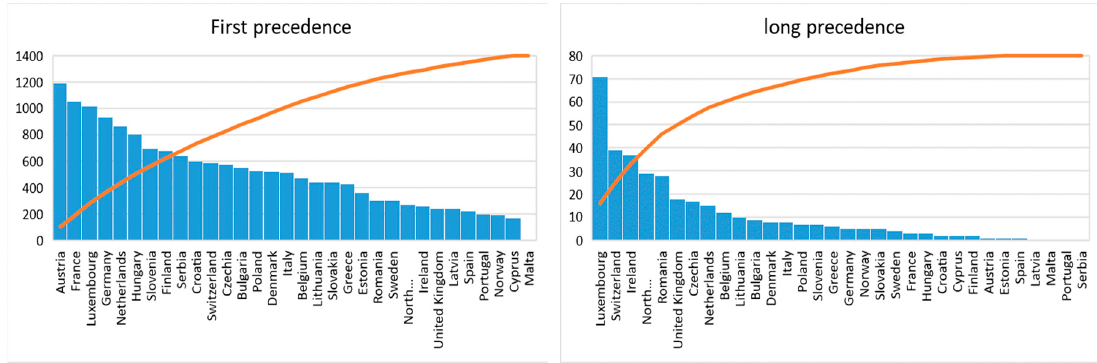
Figure 3. Total number of precedencies.